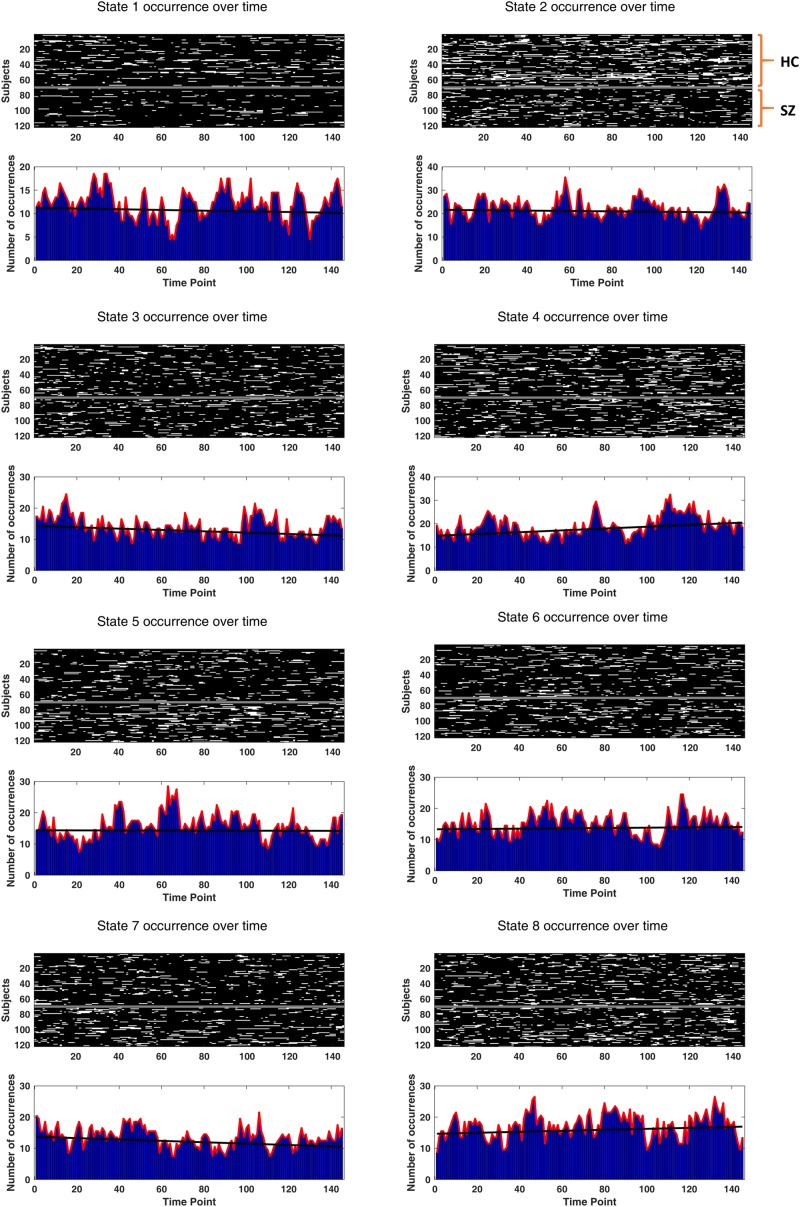
Drowsiness effect. The occurrence of each state (over time) has been depicted for each subject. The two groups (HC and SZ) have been separated by a constant (white) line, in the surface plots. Other white patches indicate the emergence of that particular state over time. In the lower bar plots, state occurrences have been accumulated over subjects, for each time point. The black fitted lines show group trends. Group trend for state 4 reveals a 3.9% increase in the expression of this state, per time sample. Only state 4 has a significantly non-zero (positive) trend (p-value = 0.034).